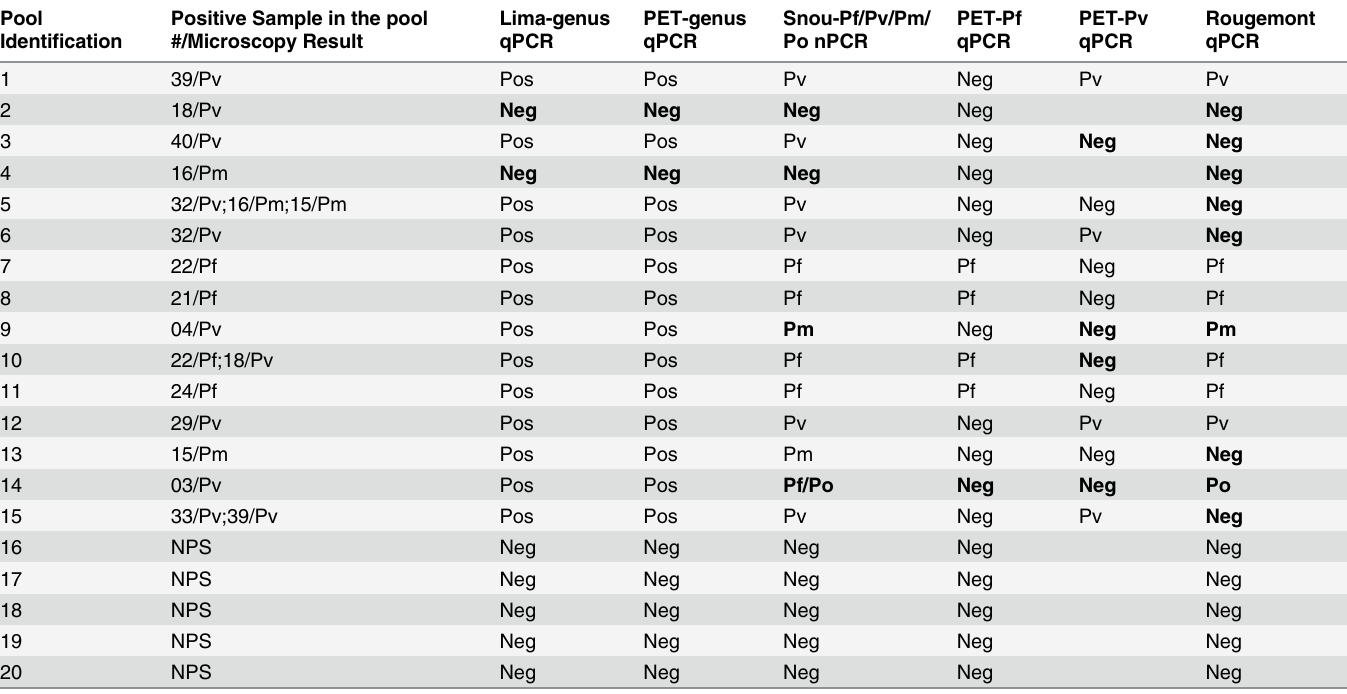
Empty boxes = Not Available; Pos = Positive; Neg = Negative; Pv = P . vivax ; Pm = P . malariae ; Pf = P . falciparum ; Po = P . ovale ; NPS = no positive sample. Discordant results with microscopy are in bold. Pools were assembled with 1 positive plus 9 negative, 2 positive plus 8 negative or 3 positive plus